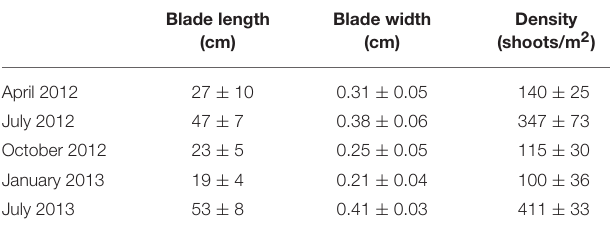
TABLE 1 | Seasonal morphometric data summarizing characteristics of Z. marina meadow in South Bay, Virginia across five sampling periods from April 2012 through July